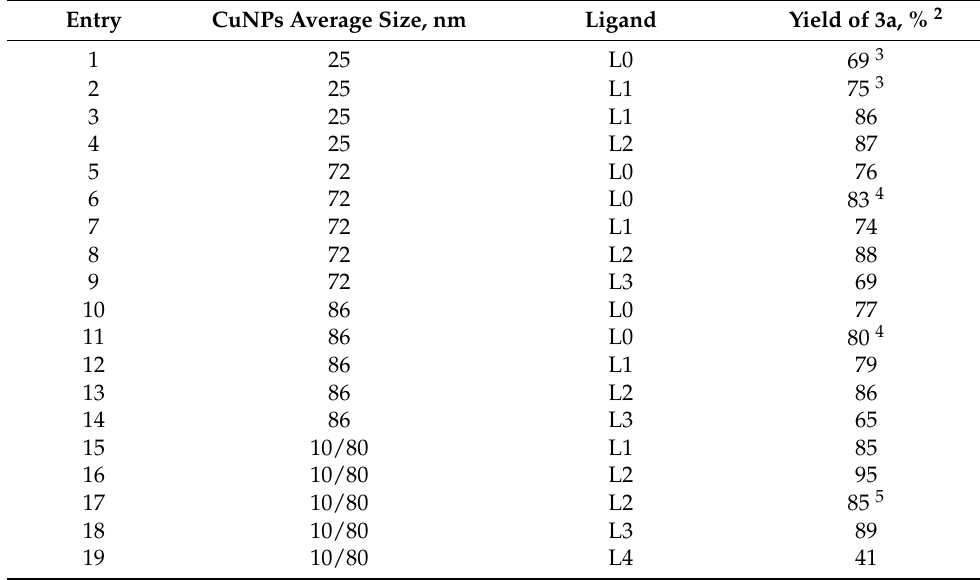
Table 1. Arylation of n -octylamine ( 1 ) with iodobenzene ( 2a ) in the presence of CuNPs 1 .